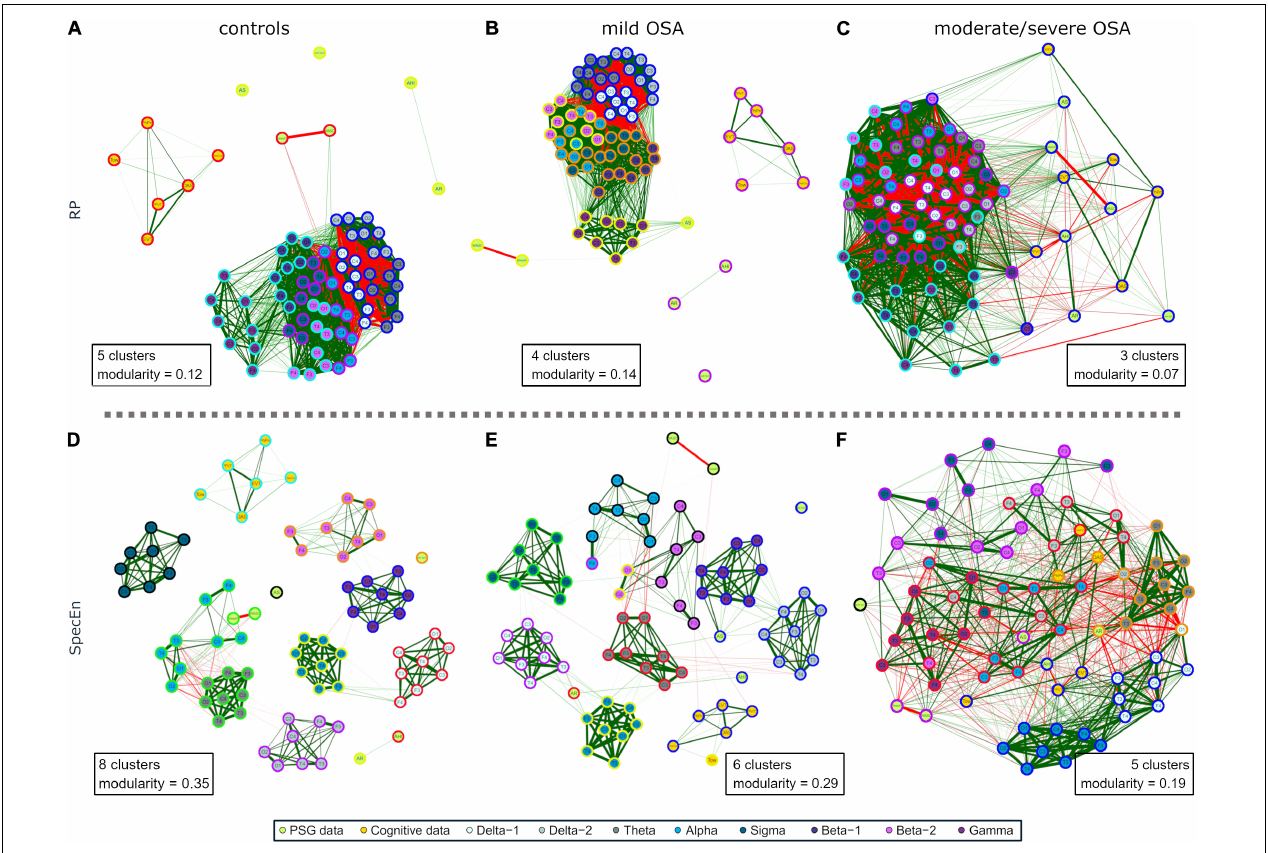
FIGURE 5 | Modularity analysis of the correlation networks of each group using (A–C) EEG activity ( RP ) and (D–F) EEG irregularity ( SpecEn ). The color of the external circles represents belonging to the same module within each correlation network.